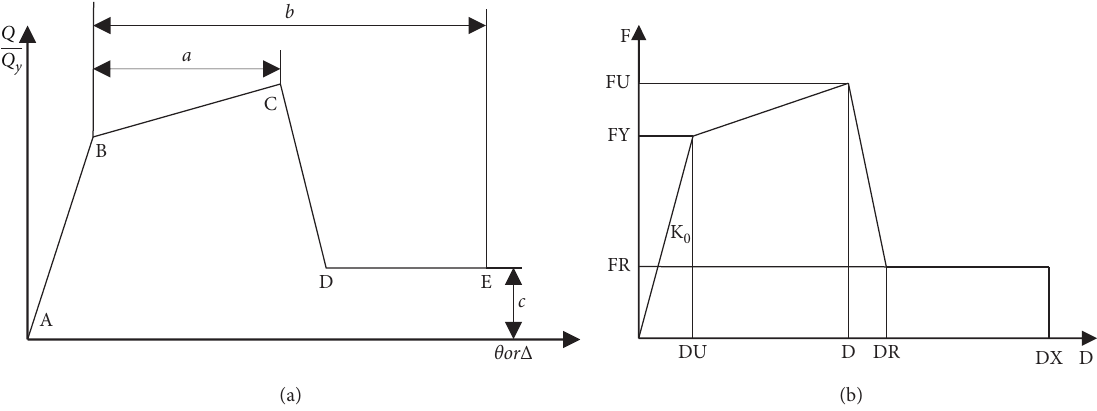
Figure 7: Force-deformation curve of the component in FEMA 356 and Perform-3D. (a) FAME 356. (b) Perform-3D.